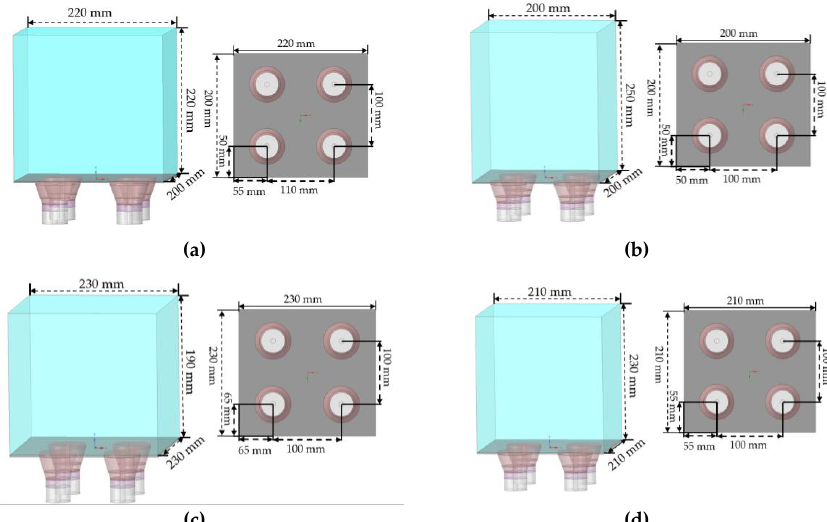
Figure 3. Diagrams and dimensions of ultrasonic cleaning tanks ( a ) model A, ( b ) model B, ( c ) model C, and ( d ) model D.